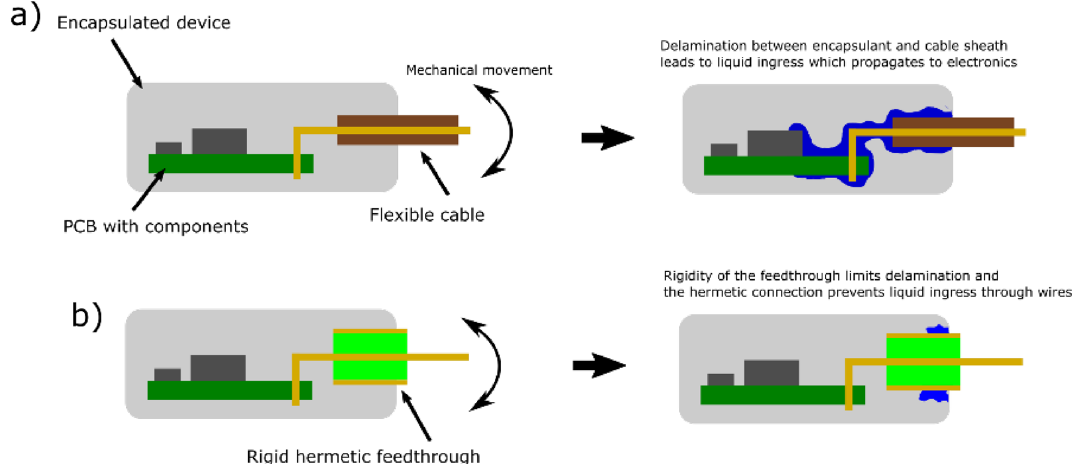
Figure 7. Probable water ingress path comparison—( a ) without hermetic feedthrough; ( b ) with hermetic feedthrough.